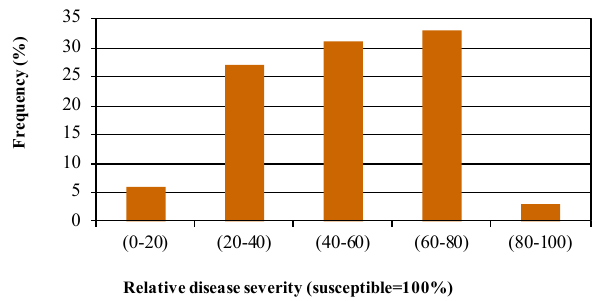
Figure 2. Relative leaf rust ( Puccinia triticina ) severity in a collec- tion of 917 Spanish wheat landraces, planted at Cordoba, Spain in 1996/97. Here reproduced with the permission of the copyright holder from Martínez et al . (2001).